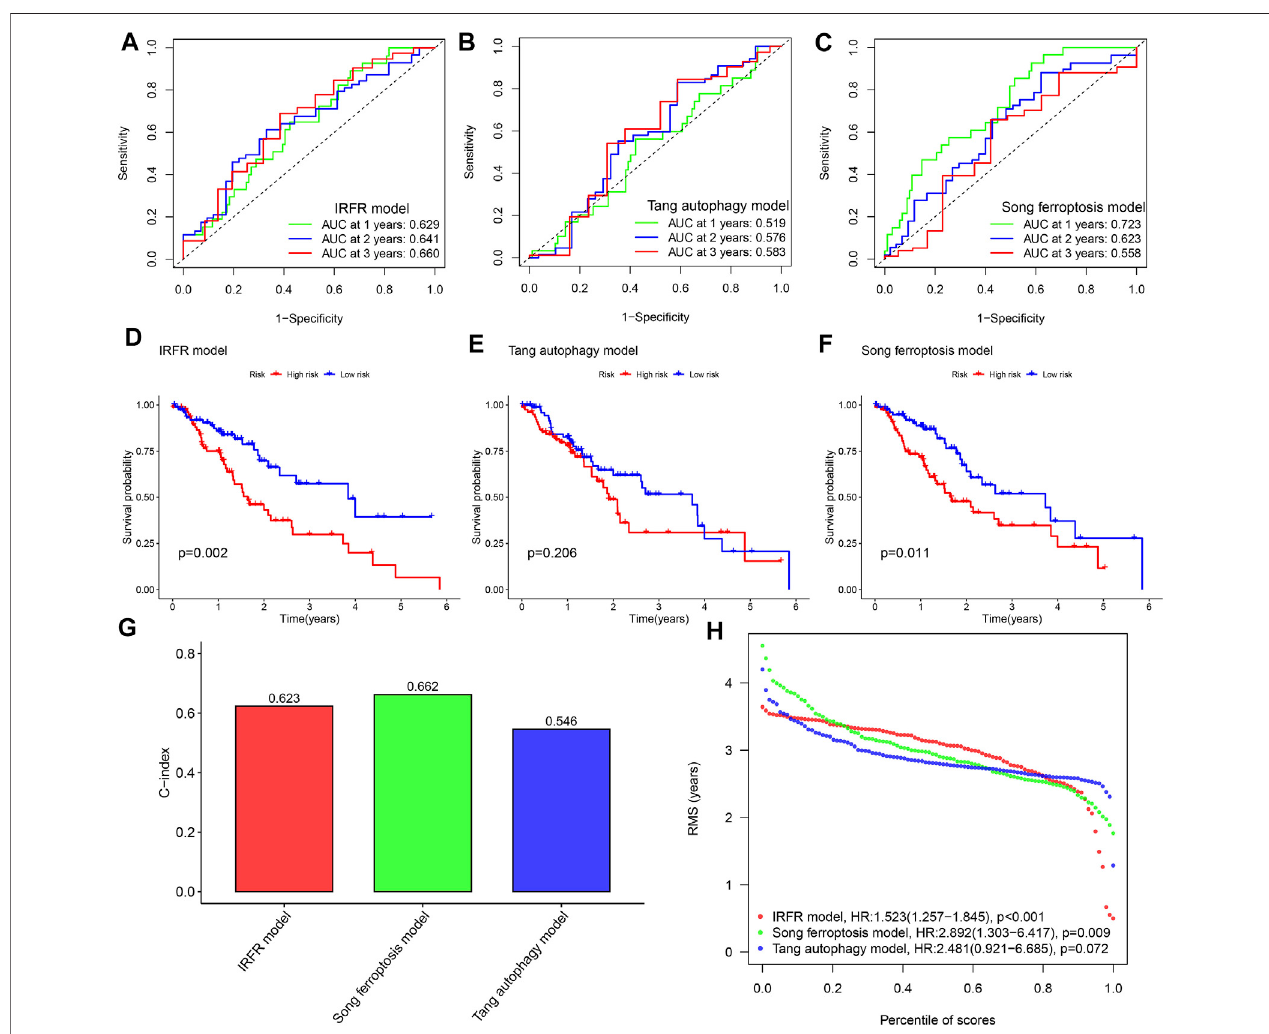
FIGURE 4 | Performance comparison among different models. (A – C) The 1, 2, and 3- years ROC curves for three models. (D – F) Kaplan-Meier survival curves for three models. (G) Comparison of C-index ofthe three models. (H) Comparison of RMST plot of the three models. IRFR model represents the model webuilt using three PR-DE-IRFeGs. Tangautophagymodelrepresentsamodel constructed byTangetal.(2021) using4autophagy-related genes.TheSongferroptosismodel represents a model constructed by Song et al. (2021) using 7 ferroptosis-related genes.